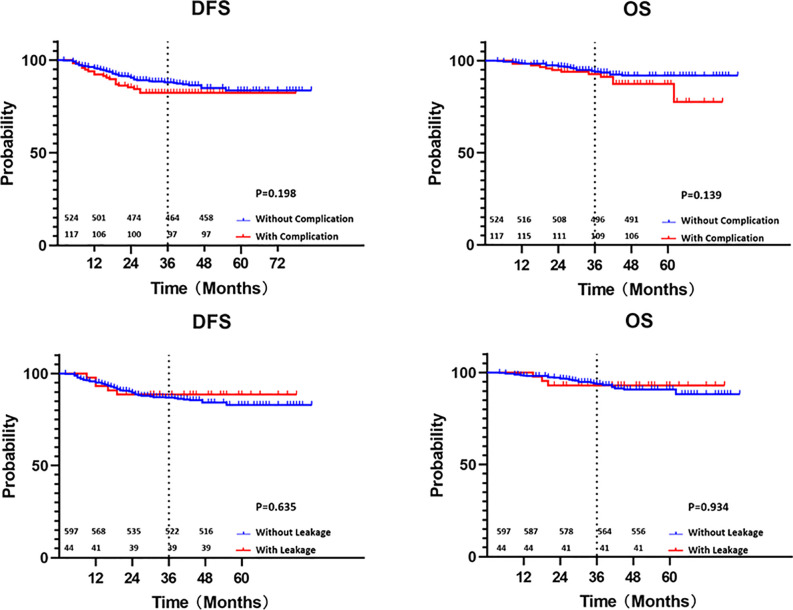
Kaplan-Meier curves of disease-free survival and overall survival with or without complication and leakage (survival numbers were added).